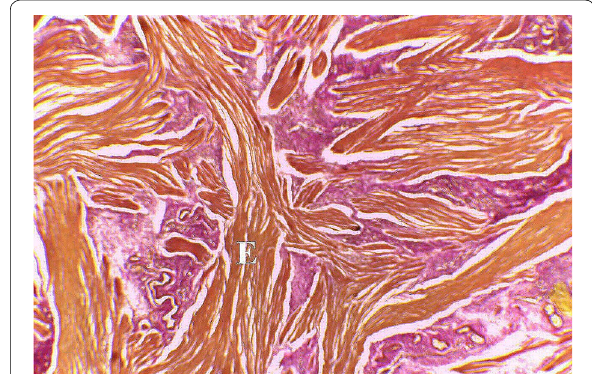
Fig. 3 Positive dark brown fibers of elastic tissue in eosinophilic background of fibrocollagenous bundles “ collagen, E elastin